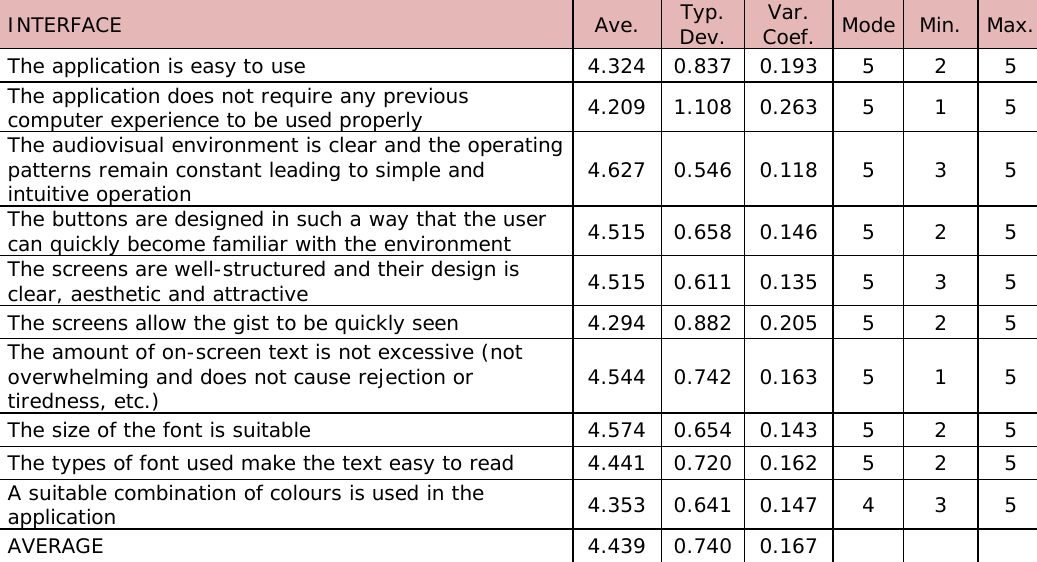
Table 1. “Assessment of